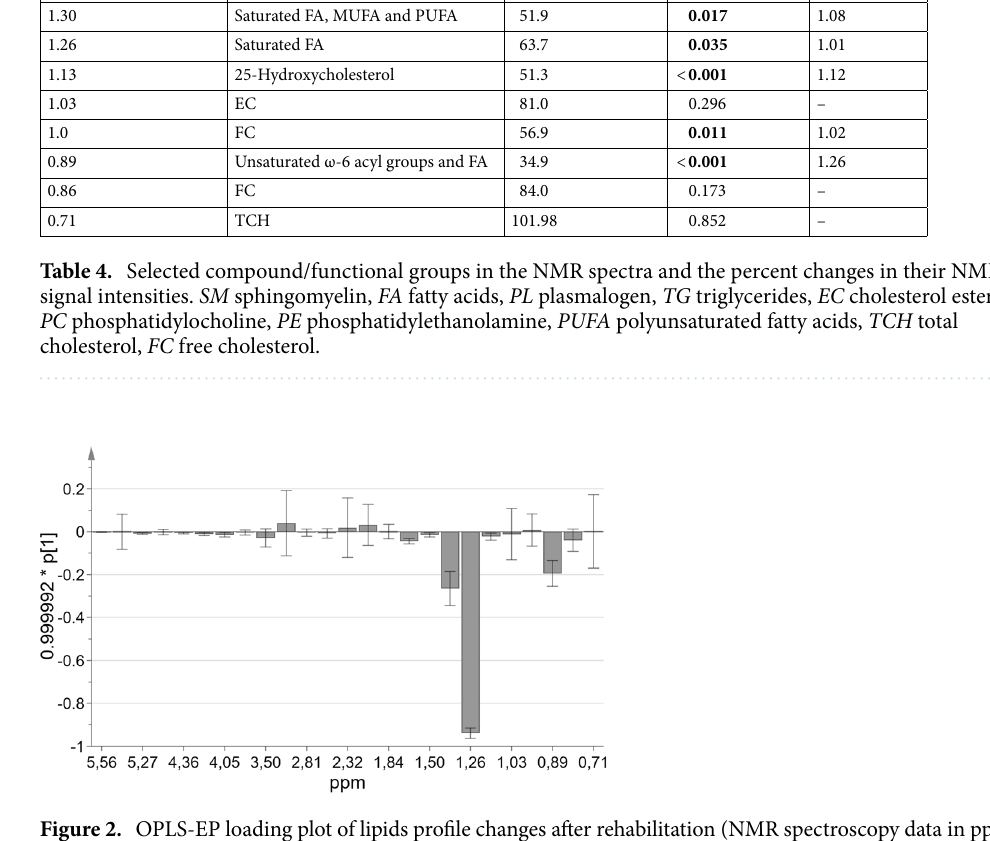
Figure 2. OPLS-EP loading plot of lipids profile changes after rehabilitation (NMR spectroscopy data in ppm of compound signal chemical shift); p[1] corresponds to the covariance between the NMR data and the predictive score vectors. OPLS-EP orthogonal partial least squares effect projection, NMR nuclear magnetic